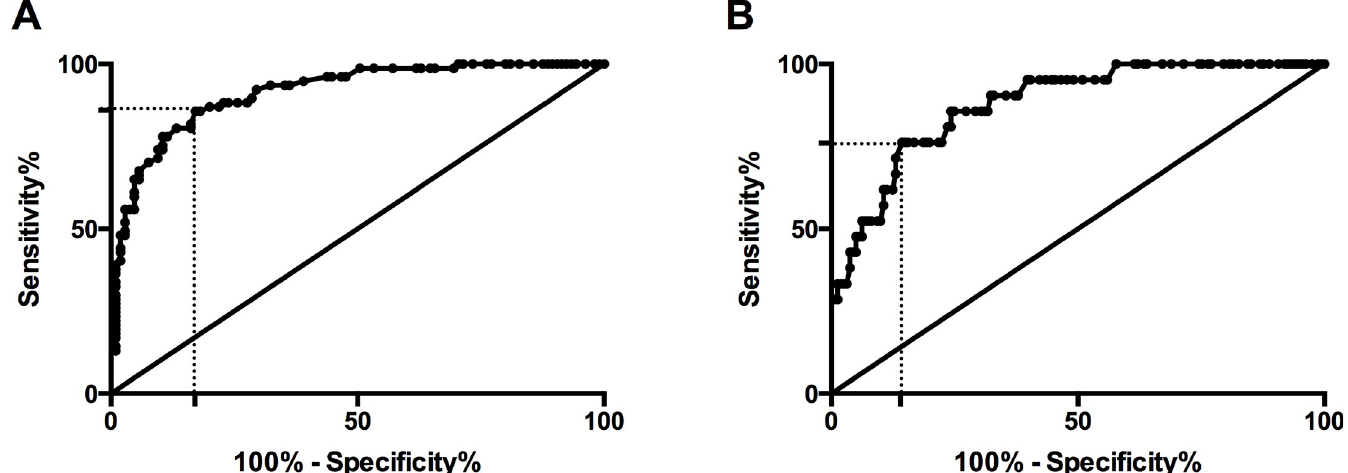
Fig 2. ROC curves for aPWV to identify cardiovascular risk according to the ST1RE for moderate/high- (panel A) and high-risk groups (panel B).